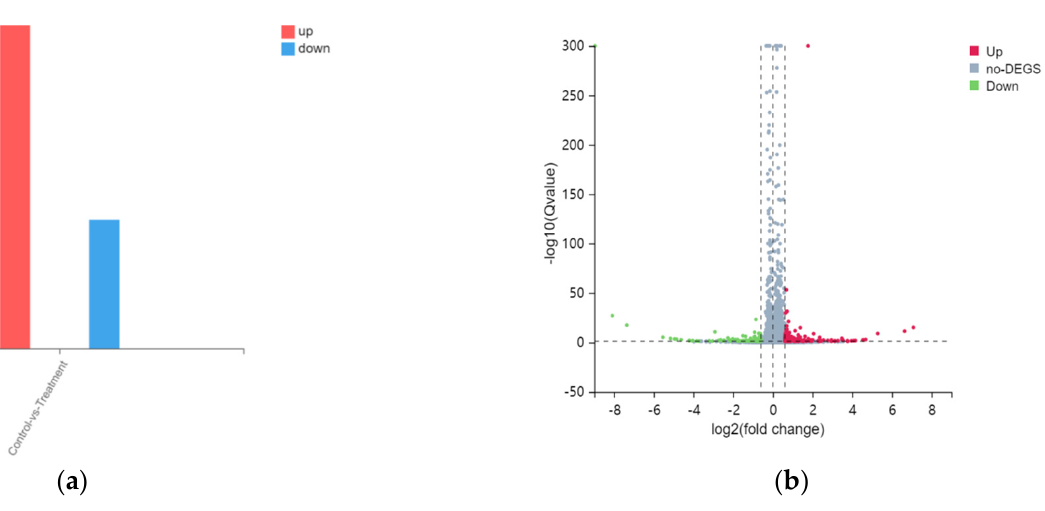
Figure 3. Difference analysis after tritium toxicity in HacaT cells. ( a ) Statistical map and ( b ) volcanic map of differential gene expression.